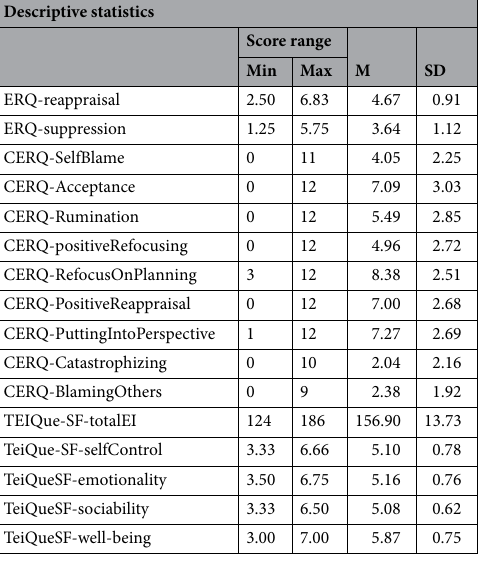
Table 4. Descriptive statistics of TEIQue-SF, ERQ and CERQ questionnaires, included their subscales for N = 79. M mean, SD standard deviation, Min and Max minimum and maximum scores for each